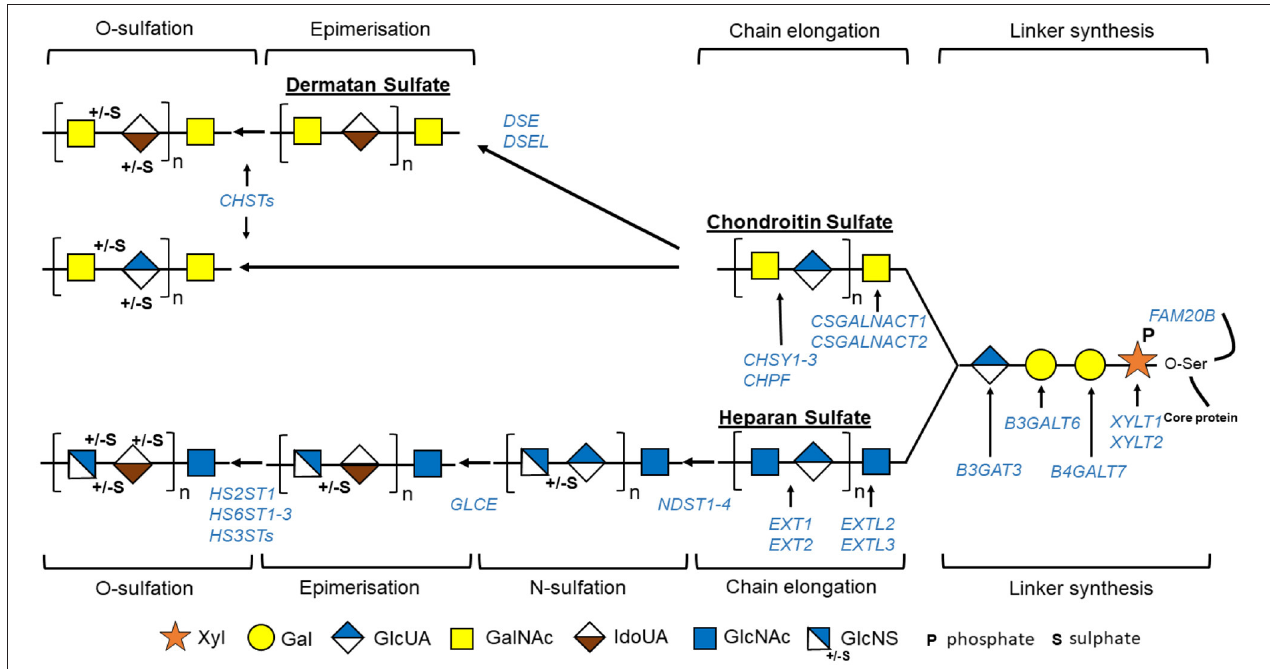
FIGURE 2 | Schematic view of GAG biosynthesis: GAG biosynthesis is initiated by sequential addition to specific serine residues of PG core protein of one xylose (Xyl), two galactoses (Gal), and one glucuronic acid (GlcUA) constituting tetrasaccharide linker region common to tree groups of GAG, i.e., heparan sulfate, chondroitin sulfate, and dermatan sulfate. GAG chains will then be elongated by binding specific repetitive disaccharides [ N -acetylgalactosamine (GalNAc) and glucuronic acid (GlcUA) for chondroitin sulfate and N -acetylglucosamine (GlcNAc) and GlcUA for heparan sulfate]. Some residues are modified: epimerization of GlcUA to iduronic acid (IdoUA) that will generate dermatan sulfate from chondroitin sulfate, or N -sulfation/ N -deacetylation of GlcNAc to N -sulfoglucosamine (GlcNS) followed by epimerization of GlcUA to IdoUA for heparan sulfate. Finally, GAGs are further modified by O-sulfation. Different enzymes implicated in these processes are indicated in blue. “HS3TSs” include seven HS3ST (HS3ST1, 2, 3A, 3B, 4, 5, and 6), and “CHSTs” include four chondroitin-4-O-sulfotransferases (CHST11-14), two chondroitin-6-O-sulfotransferases (CHST3 and 7), one GalNAc-4-O-sulfate-6-O-sulfotransferase (CHST15), and one